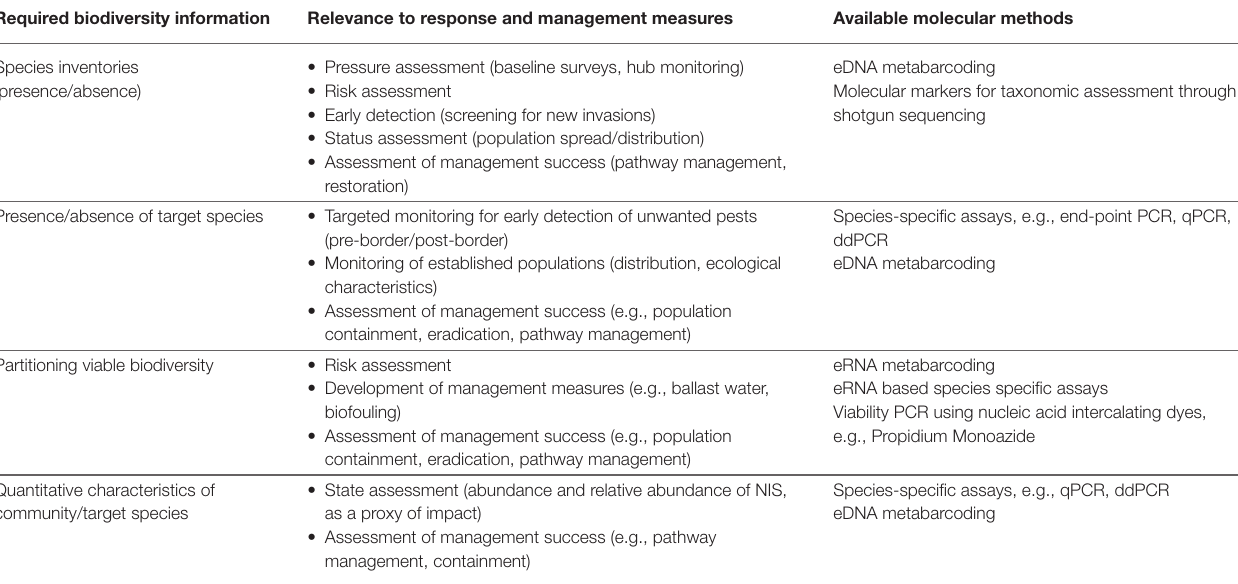
TABLE 1 | Biodiversity information required for science-based biosecurity programmes, its relevance to specific management applications and available eDNA/eRNA methods for deriving this information. Required biodiversity